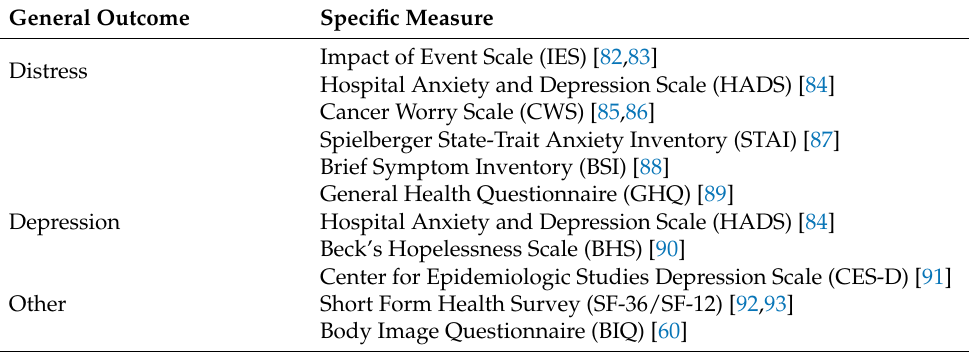
Table 2. General outcomes and respective measures included in this review. General Outcome Specific Measure Impact of Event Scale (IES) [82,83] Distress Hospital Anxiety and Depression Scale (HADS) [84] Cancer Worry Scale (CWS) [85,86] Spielberger State-Trait Anxiety Inventory (STAI) [87] Brief Symptom Inventory (BSI) [88] General Health Questionnaire (GHQ) [89] Depression Hospital Anxiety and Depression Scale (HADS) [84] Beck’s Hopelessness Scale (BHS) [90] Center for Epidemiologic Studies Depression Scale (CES-D) [91] Other Short Form Health Survey (SF-36/SF-12) [92,93] Body Image Questionnaire (BIQ)